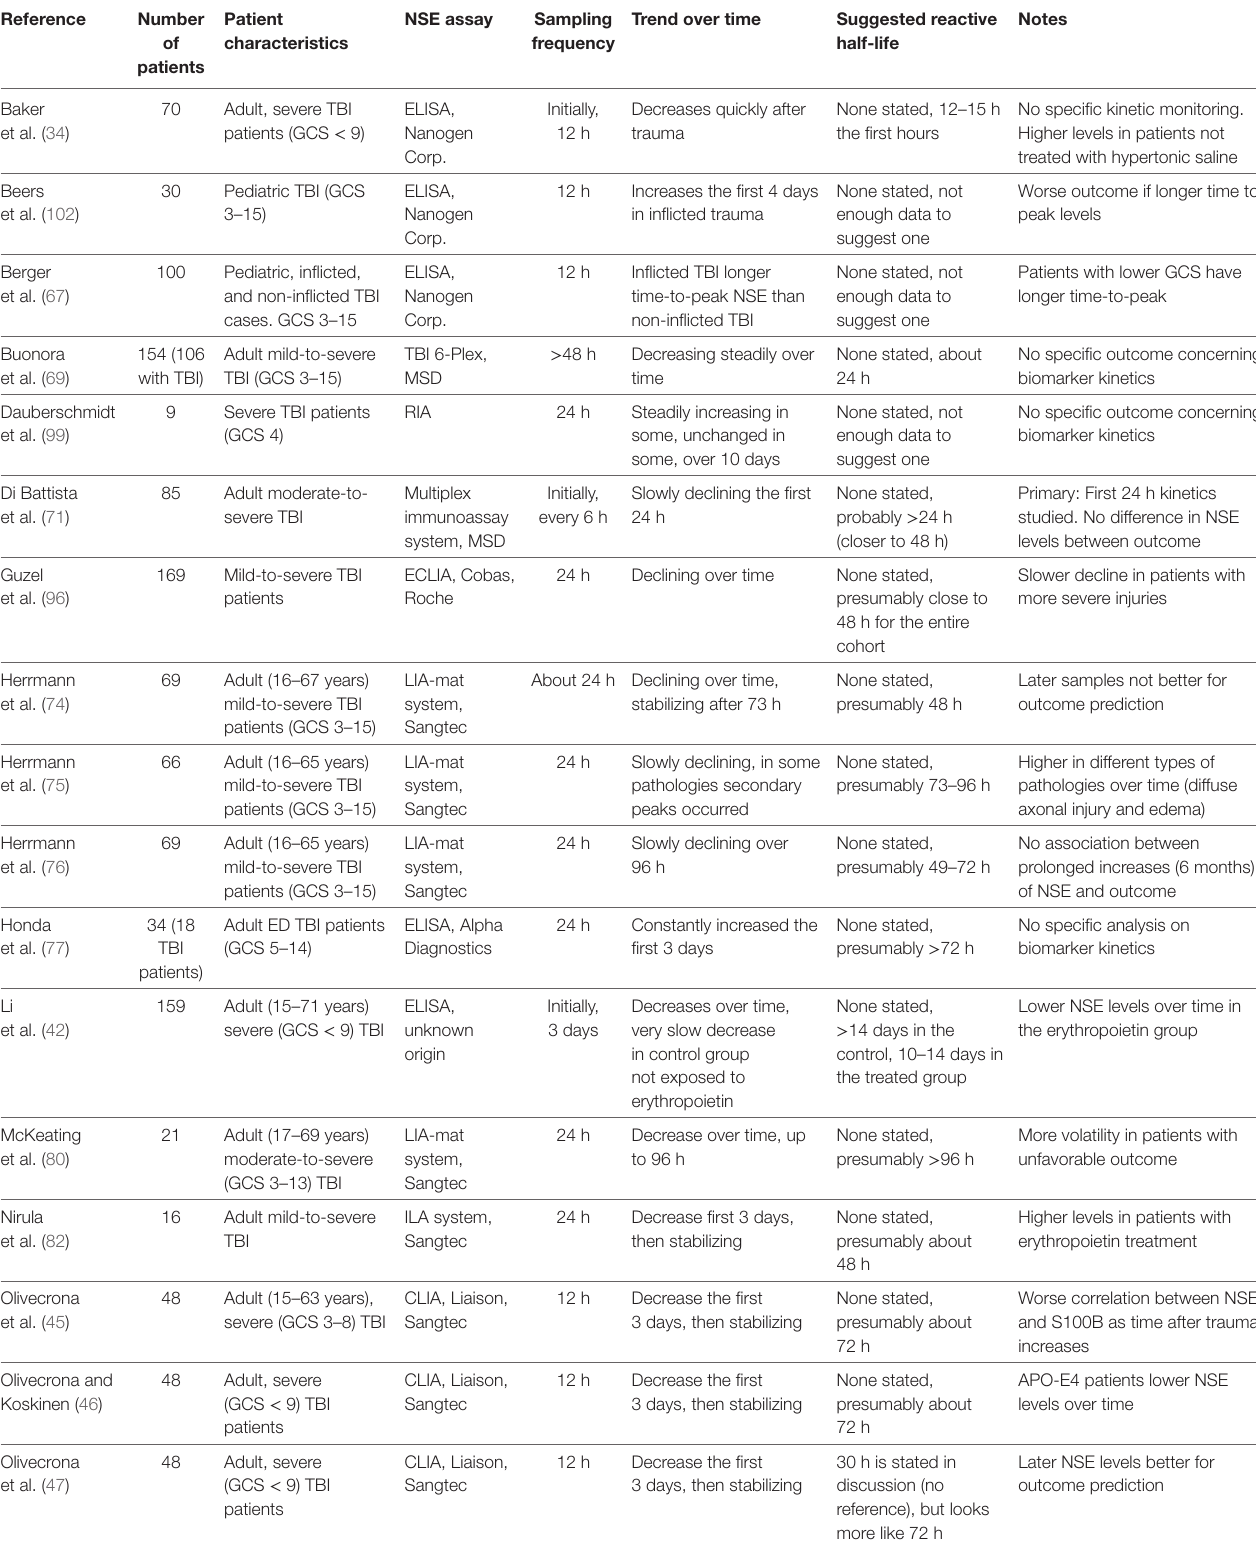
TABLe 2 | Analysis of NSE